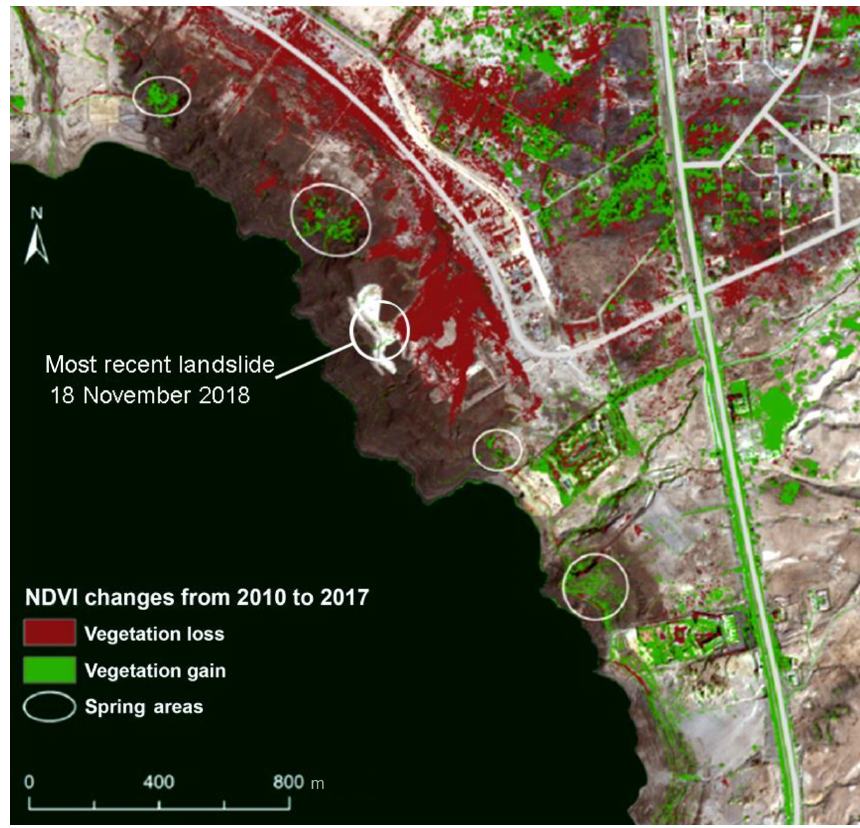
Figure 7. Vegetation change detection map obtained from NDVI difference between 2010 and 2017 in the north-eastern part of the study area. The white circles highlight the areas along the coastline where new springs appeared in correspondence with vegetation increases.